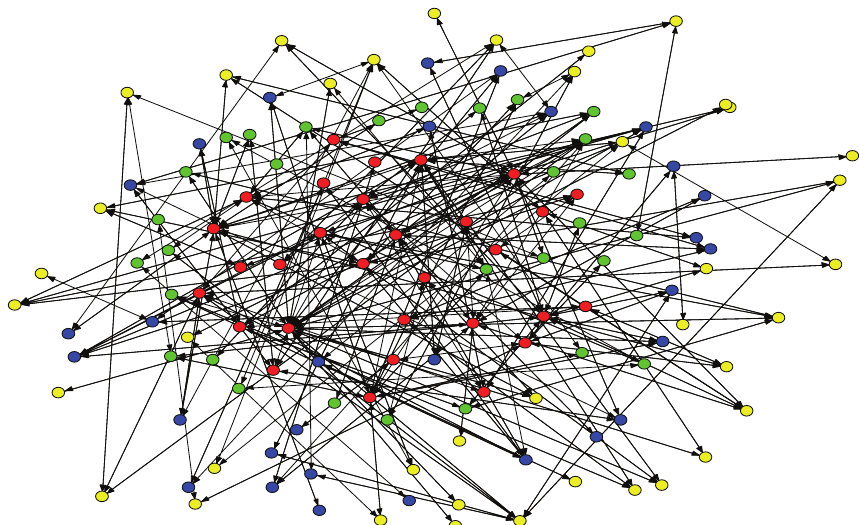
Figure 3: The distribution and connectivity of 130 nodes in the network generated by Inet3.0.